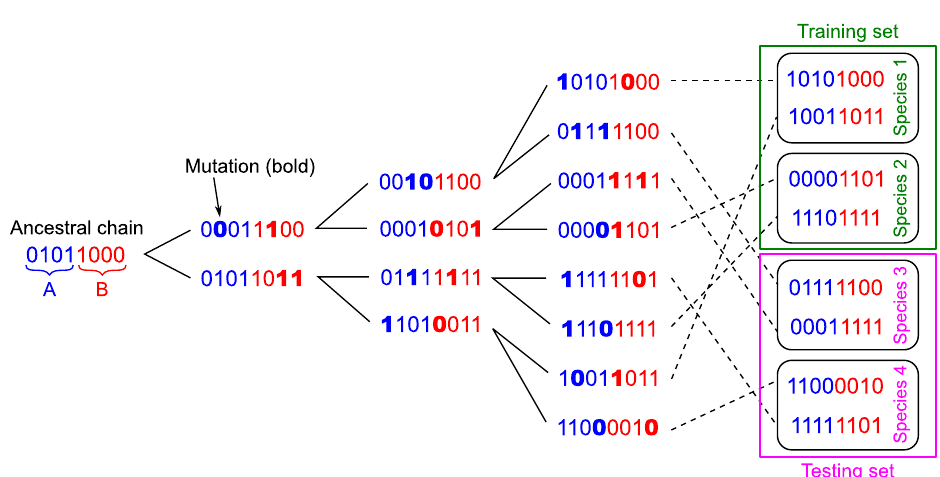
Fig 1. Construction of a synthetic dataset of chains sharing evolutionary history. Starting from a random ancestral chain AB of bits whose two halves A and B are shaded in blue and red, a series of n duplication and mutation steps (“generations”, here n = 3) are performed (bold: mutated bits; here 2 bits per chain are mutated at each step), resulting in 2 n = 8 chains. Species are then constructed randomly, here with m = 2 chains per species. Some species are considered as the training set (green), and the other ones constitute the testing set (pink), where the pairings between each chain A and each chain B will be blinded.